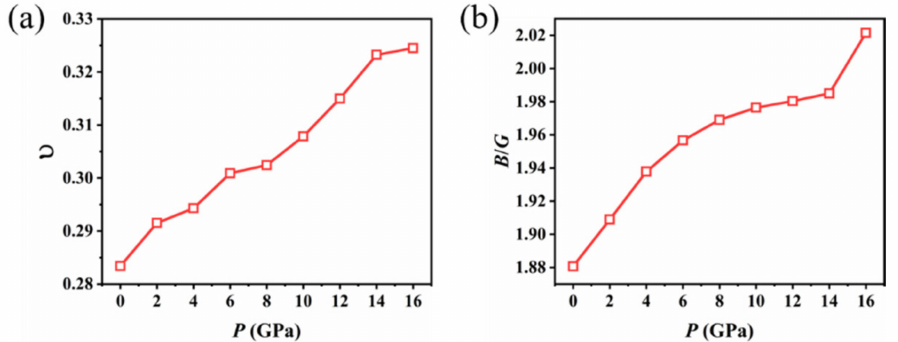
Figure 6. ( a ) Poisson’s ratio and ( b ) Pugh’s modulus ratio of single-crystal tungsten as a function of